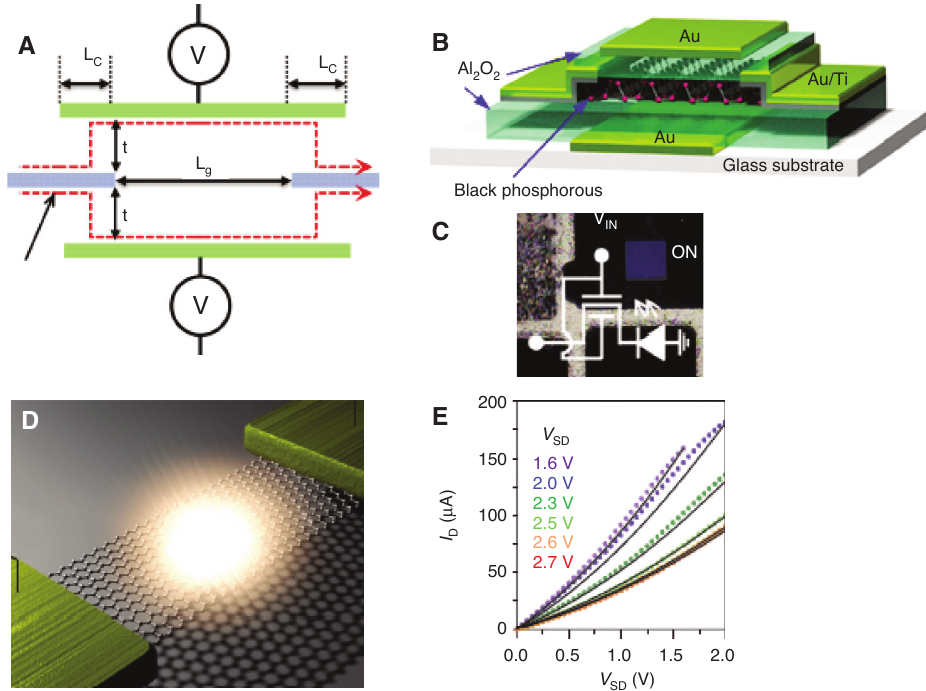
Figure 9: Graphene plasmonic logic gate, blue OLED in BP FET and visible light emission in graphene [149–151]. (A) Basic switching unit of the graphene plasmonic MZI logic gate [149]. (B) Schematic 3D view of the dual-gate BP FET. (C) Photographic images display blue OLED under turn-off and -on states [150]. (D) The suspended monolayer graphene devices with bright visible light emission under electrically bias voltage. (E) ID-VSD relation in graphene. Solid curves are the calculated results with the transport model